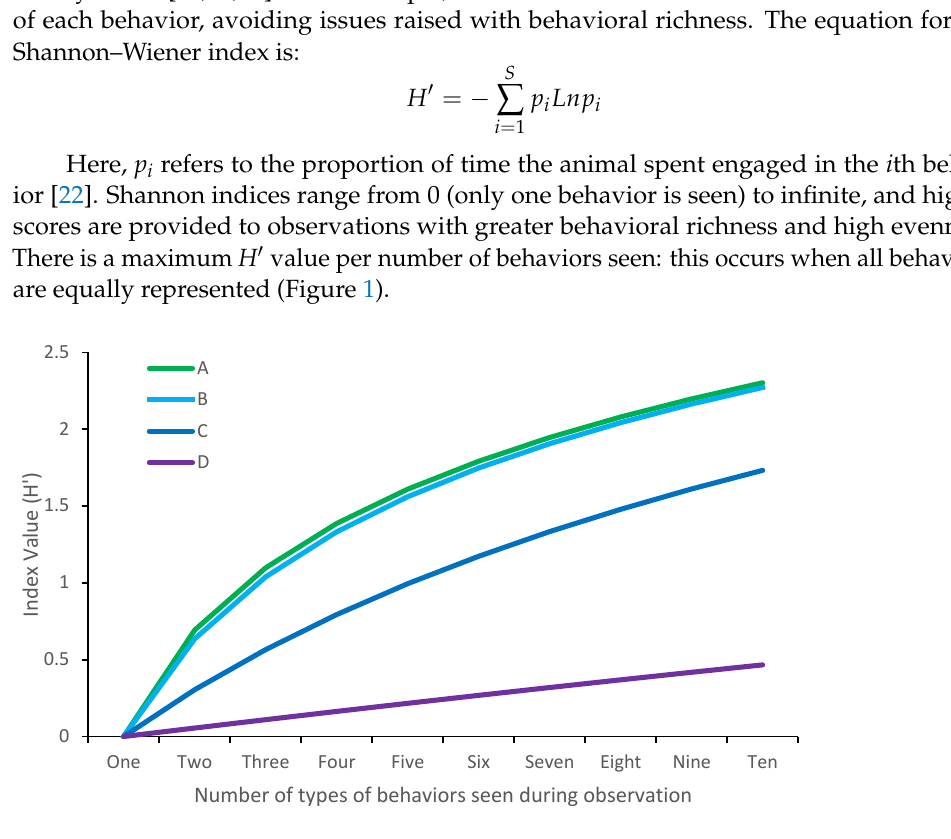
Figure 1. The effect of number of behaviors seen on Shannon–Wiener index outputs, using simulated data. Simulation A demonstrates H’ outputs when all behaviors are seen an equal number of times. Simulation B, C and D demonstrate H’ outputs when all behaviors occur equally frequently, apart from the first behavior which occurs 2 × , 10 × or 100 × , respectively, more frequently than the